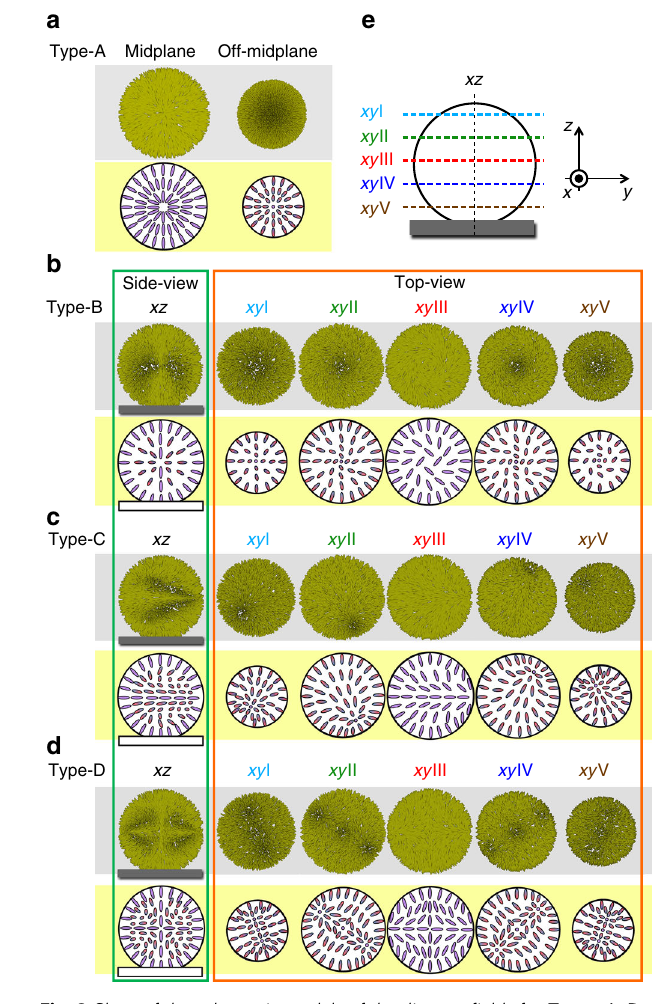
Fig. 8 Chart of the schematic models of the director fi elds for Types-A – D. a Type-A, b Type-B, c Type-C, and d Type-D. The upper rows are the numerically depicted nematic directors at certain cross-sectional positions using the trial functions, with Supplementary Equations (1) and (2) for Type-A and Type-B, Supplementary Equations (3) and (4) for Type-C, and Supplementary Equations (5) and (6) for Type-D. The lower rows are the simpli fi ed cartoons of the corresponding director fi eld using ellipsoids to show the point-by-point distributions of the directors projected onto the plane. The colour gradation of the ellipsoids from red to blue represents the director tilt from up to down against the plane. For Type-A, only two horizontal cross-sections at the midplane and off-midplane are shown. For each of the other three types, one vertical ( xz ) and fi ve different horizontal ( xy I – xy V) cross-sectional positions are chosen according to the schematic ( e ). Note that xy III corresponds to the equatorial plane ( = reconstruct the POM image well. Of course, this simulation strongly supports the validity of the director model for Type-C. Note that Type-C always appears with a texture similar to that in Fig. 1c, which means a fi xed orientation with winding in the viewing direction, as shown in Fig. 8c.